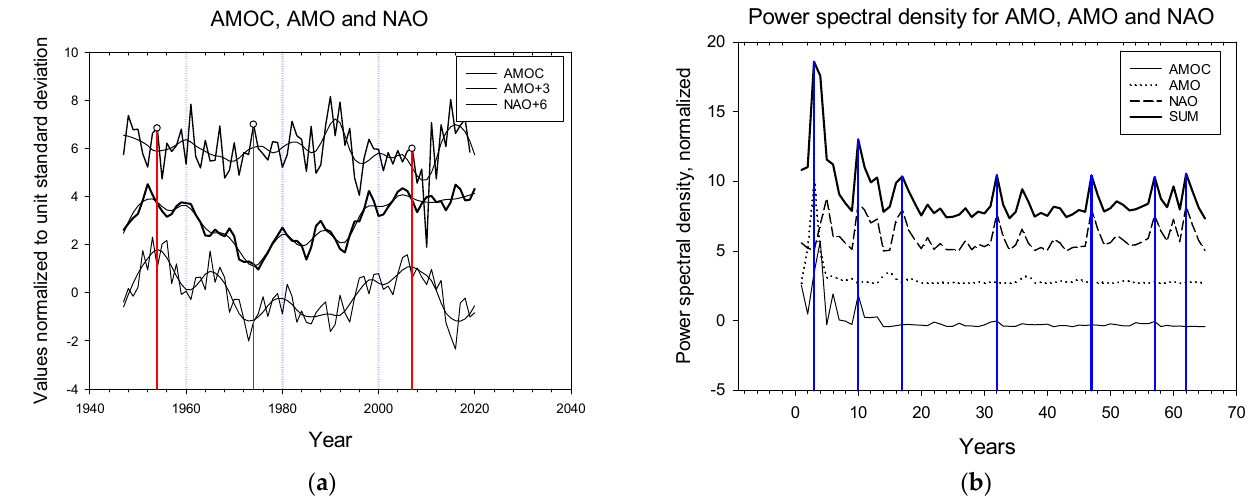
Figure 2. AMOC, AMO and NAO. ( a ) Time series raw and LOESS(0.3)-smoothed. The detrended and LOESS(0.3)-smoothed versions of AMOC shifts sign from starting with (+) in 1947, then 1969, 1997, 2010. AMO starting from (+) in 1947, 1996, 1999. NAO starting from (+) in 1947, 1952, 1972, 1997, 2014, 2020. ( b ) Power spectral density. Peaks at 3, 10, 17, 32, 47, 57, and 62 years.